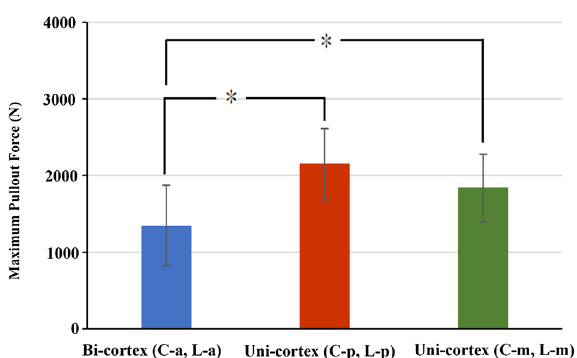
Figure 6. Mean maximum pullout forces for the bicortical purchased screws in anterior position and unicortical purchased screws in the posterior and middle position. Groups with statistically significant difference (p < 0.05) are indicated with “*”